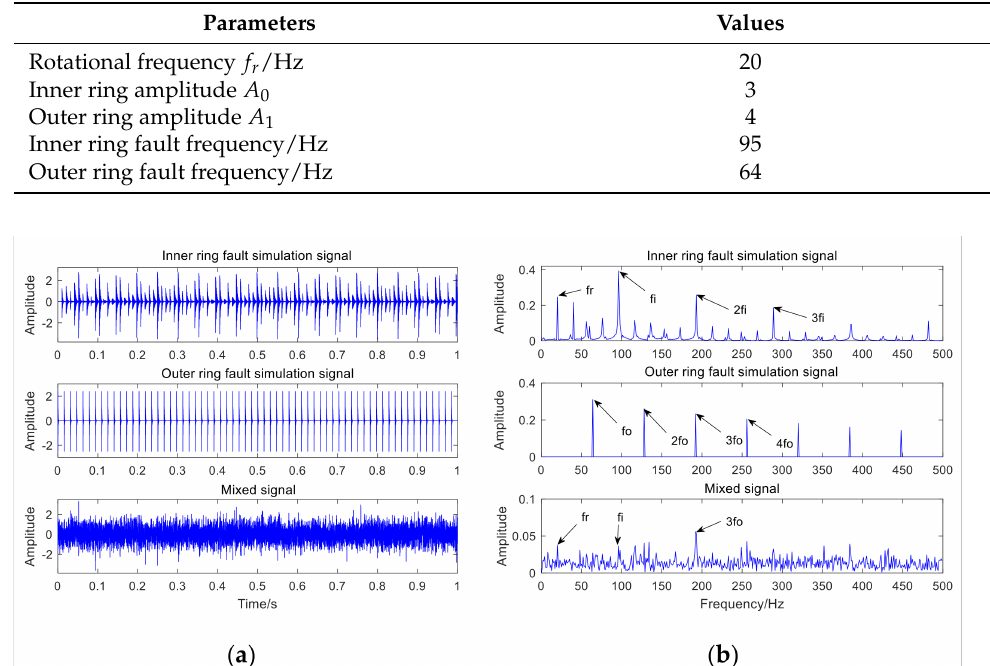
Figure 3. Time and spectral domain results of simulation signals: ( a ) time-domain waveform of the simulation data; ( b ) envelope spectrum of the simulation